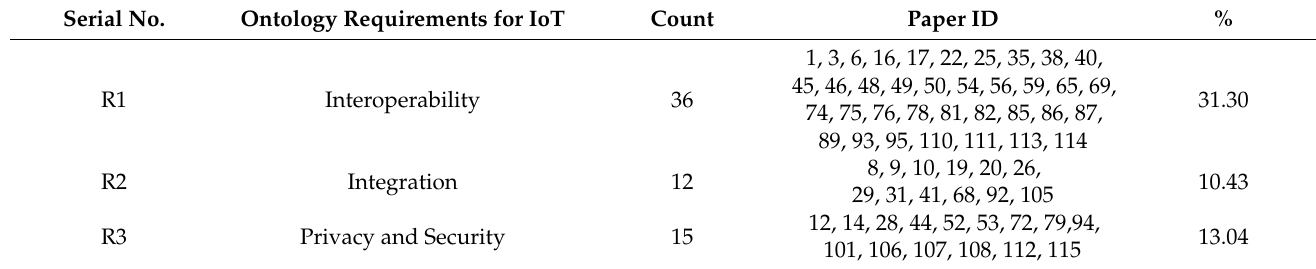
Table 3. Requirements of Ontology in